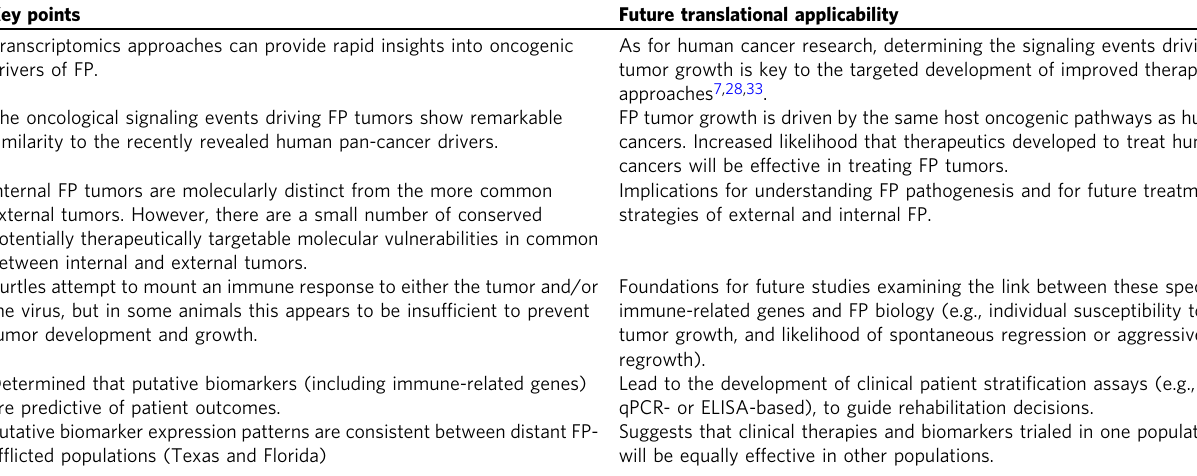
Table 2 Summary of key study fi ndings and their potential future translational